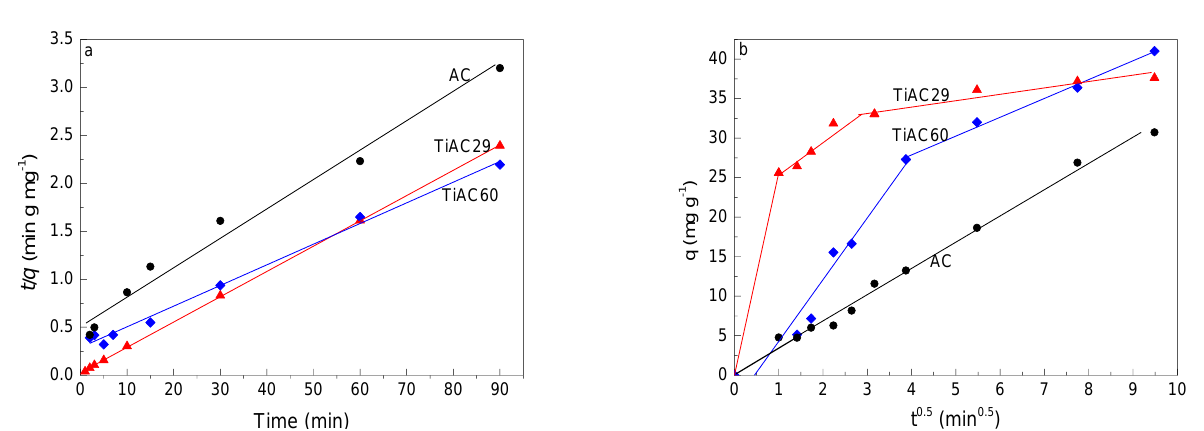
Figure 10. Pseudo-second-order kinetics plots ( a ) for the adsorption of MB onto bare AC and composites, and ( b ) Weber and Morris intra-particle diffusion plots (dosage = 0.5 g dm −3 , V = 0.02 dm 3 , [MB] = 25 mg dm −3 ).